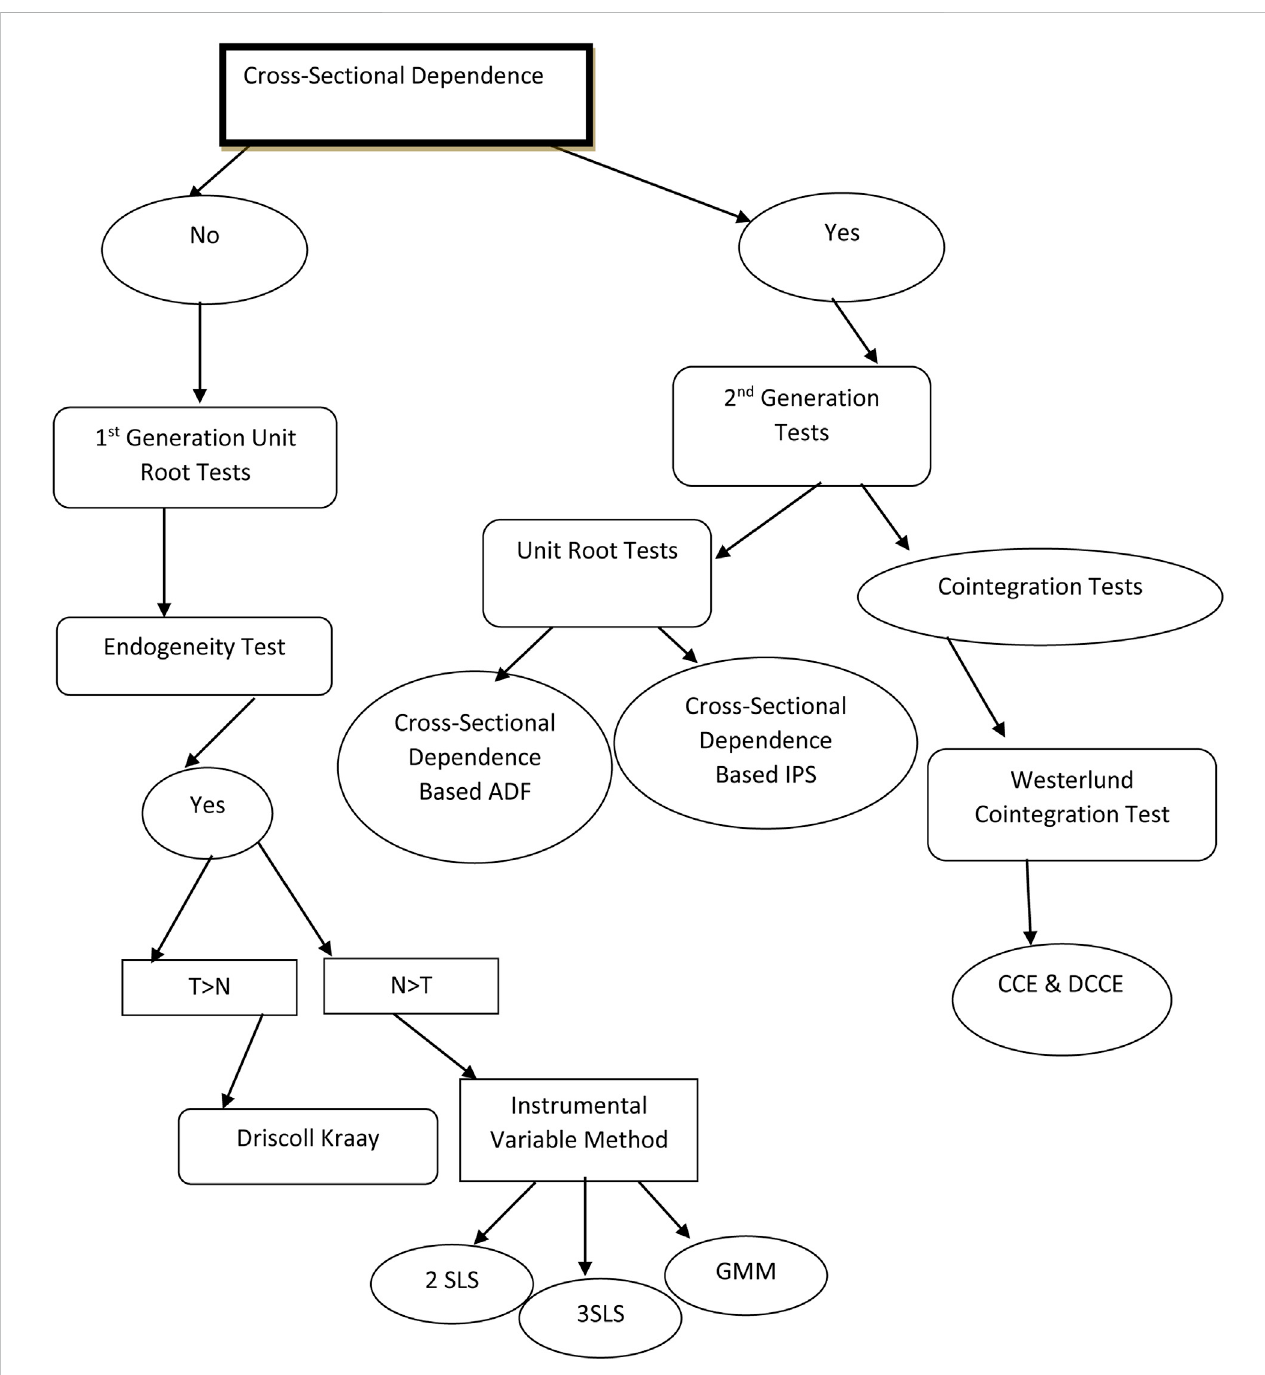
Methodological roadmap. Source: Own